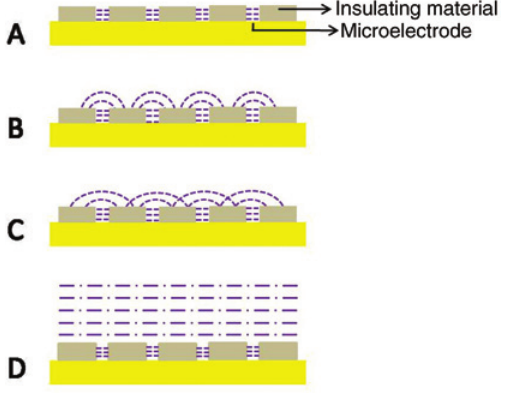
Figure 1: Schematic diagram of four types of diffusion modes for MEAs. (A) Planar diffusion at each microelectrode; (B) radial diffu- sion at each microelectrode; (C) partial overlap between diffusion layers (mixed diffusion mode between planar and radial diffusion); (D) planar diffusion over the whole array